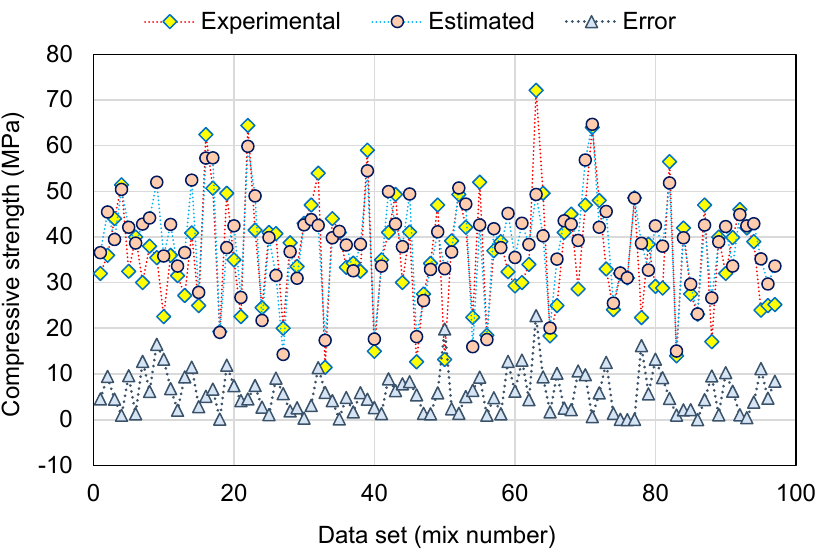
Figure 11. Distribution of experimental, estimated, and error values for the multi-layer perceptron neural network model.